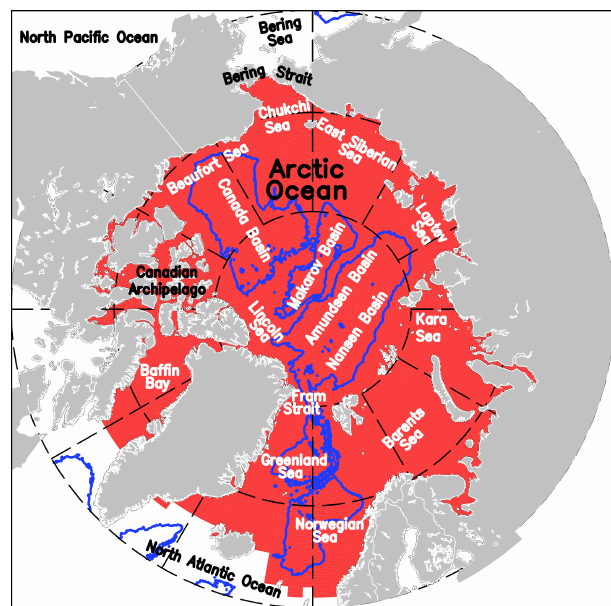
Figure 1. Red fill marks the Arctic Ocean Basin in WOD. This includes the Arctic Ocean basin and its marginal seas, the Chukchi, Beaufort, Lincoln, Greenland, Norwegian, Barents, Kara, Laptev, and East Siberian